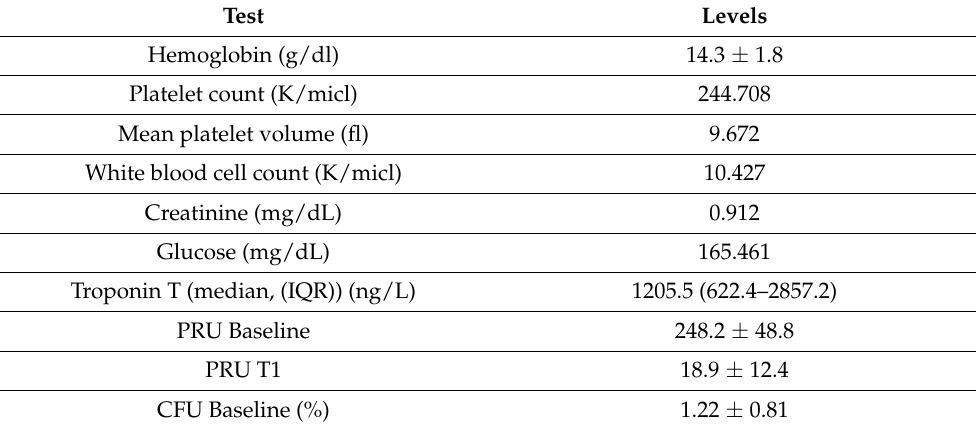
Table 2. Laboratory